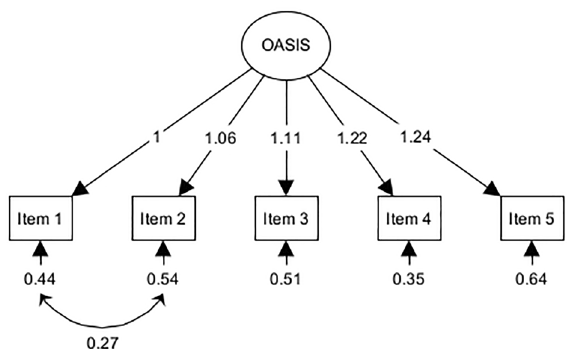
Figure 1. Confirmatory factor analysis for one-factor solution with residual correlation between items 1 and 2. Rectangles symbolize measured variables and the circle the latent construct. Standardized coefficients are given for item factor loadings and error